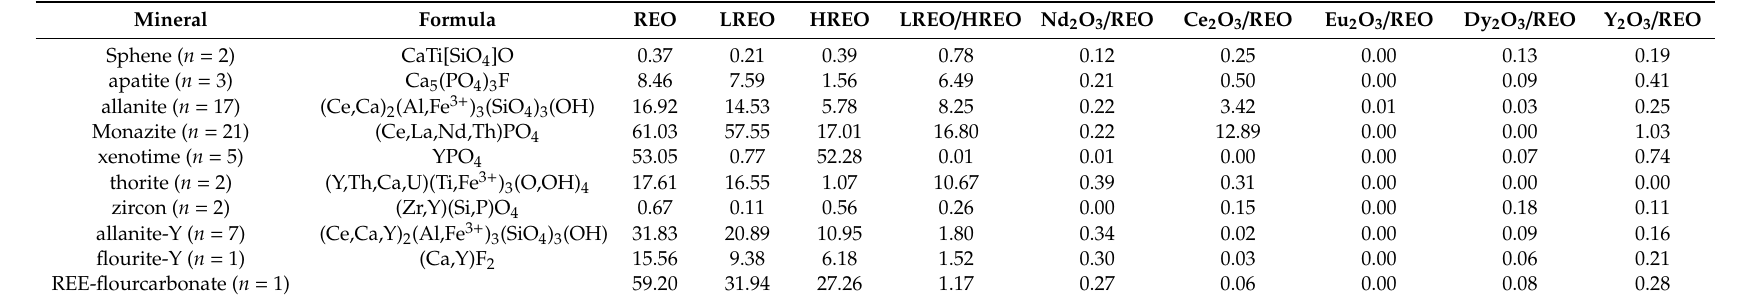
Table 1. REE geochemical characteristics in REE minerals from the QN and MH granites